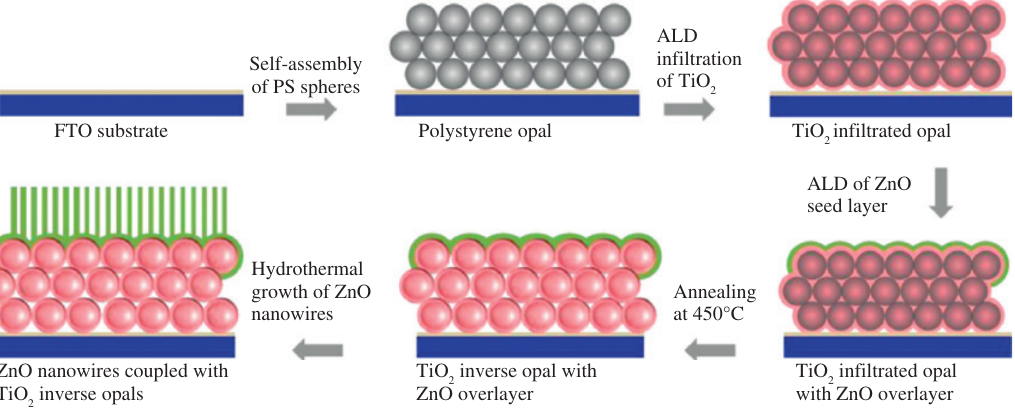
inverse opal is coupled with ZnO nanowire arrays. 2